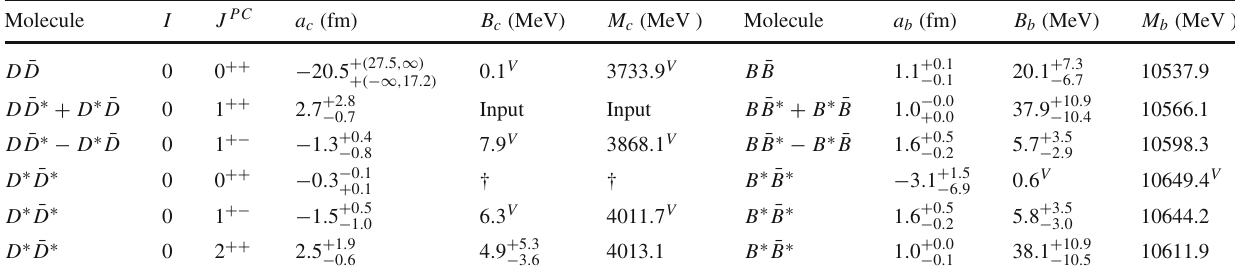
Table 3 Scattering lengths ( a in fm), binding energies ( B in MeV if bound states exist) and mass spectra ( M in MeV) of prospective isoscalar heavy antimeson–meson molecules. The † symbol indicates that there is no bound state. The subscript V denotes the existence of a